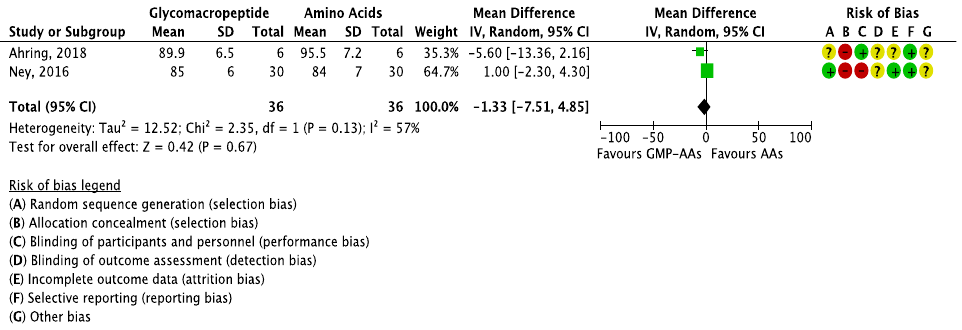
Figure 7. Forest plot of studies with data on the effect of glycomacropeptide interventions on glucose levels. The analysis included data from two studies with a total of 72 participants. AAs: synthetic protein derived from L-amino acids; CI: confidence interval; df: degrees of freedom; GMP-AAs: glycomacropeptide supplemented with amino acids; IV: intravitreal; SD: standard deviation.